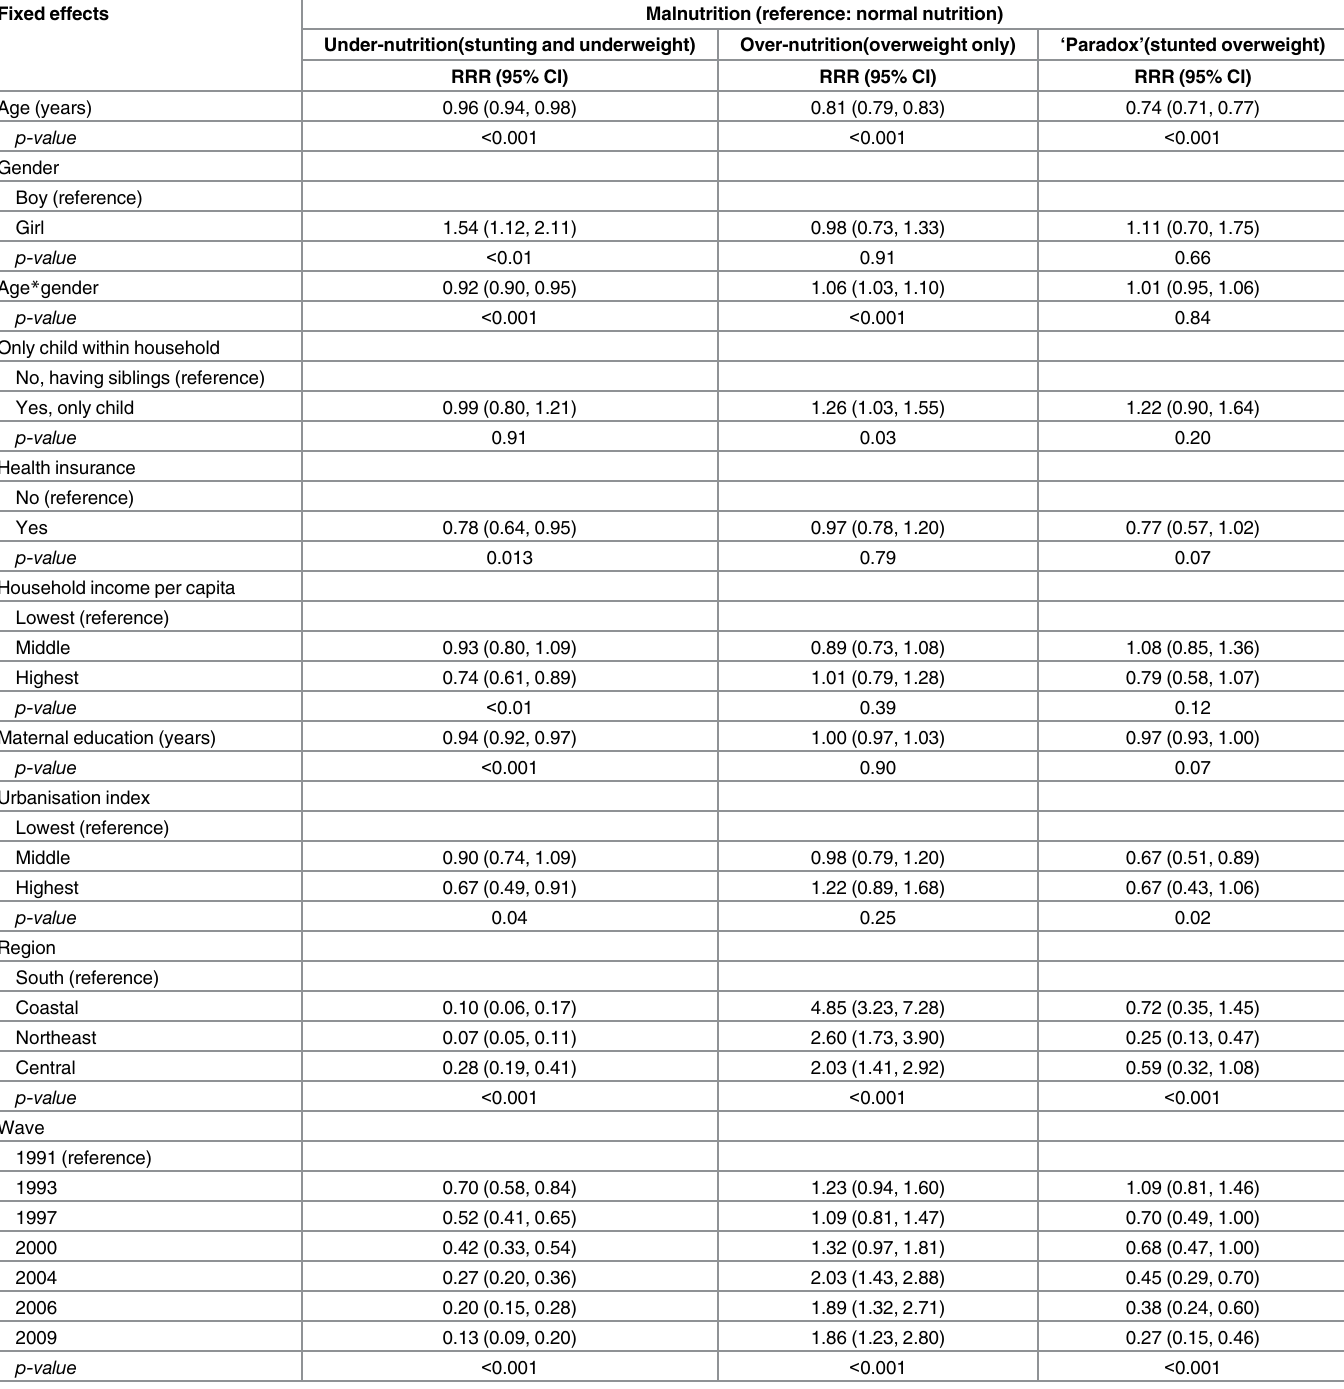
Table 5. Adjusted relative risk ratios (RRR) and 95% confidence intervals (CI) for predictors of unordered multinomial logistic models [using nor- mal nutrition without being stunted, underweight or overweight as the reference] with the interaction of age and gender predicting malnutrition for children less than 18 years from the CHNS, 1991 –